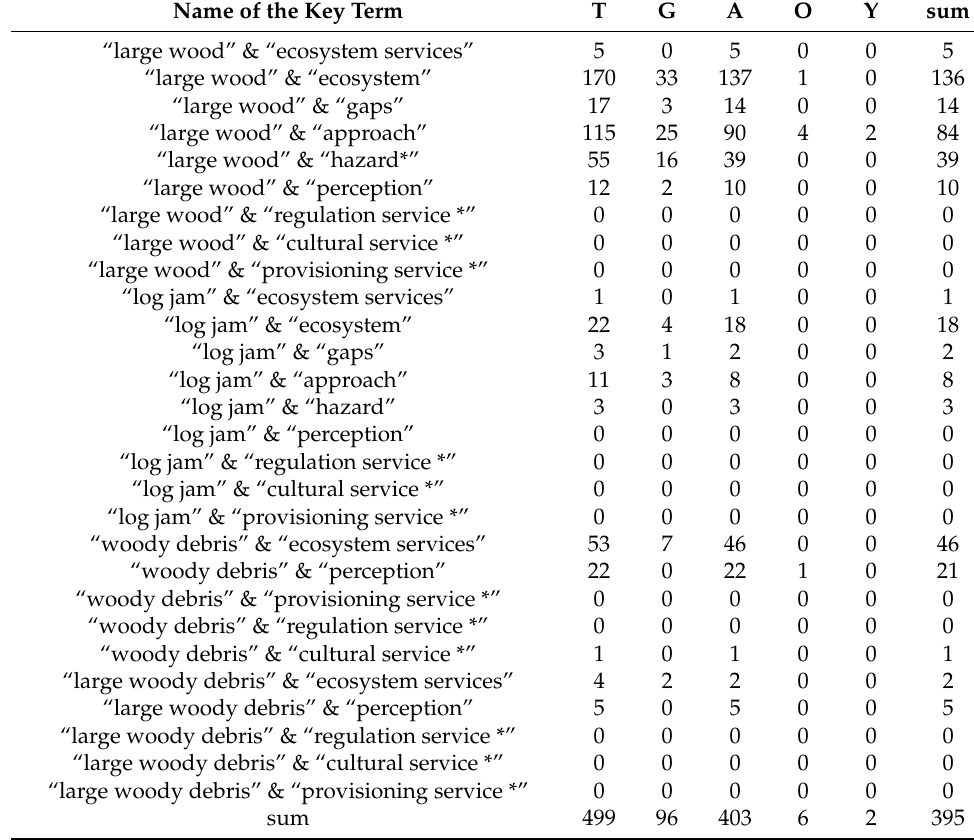
Table 3. The search terms and number of articles for each search (&—and, T—total found, G—grey literature, A—articles, O—other language than English, Y—year of publishing